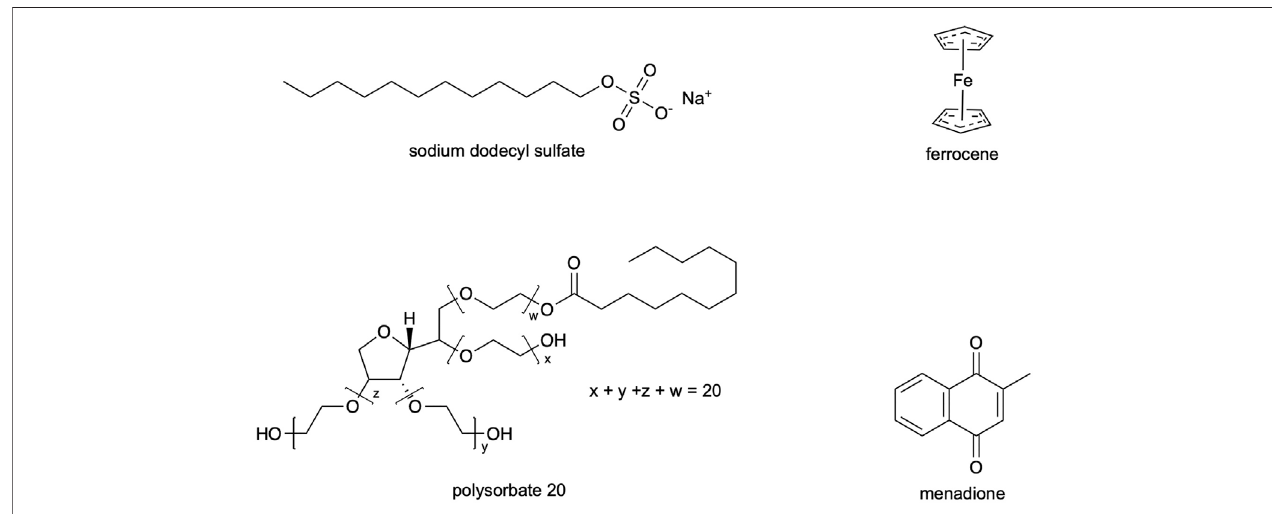
FIGURE 1 | Chemical structures of surfactants and electroactive species.